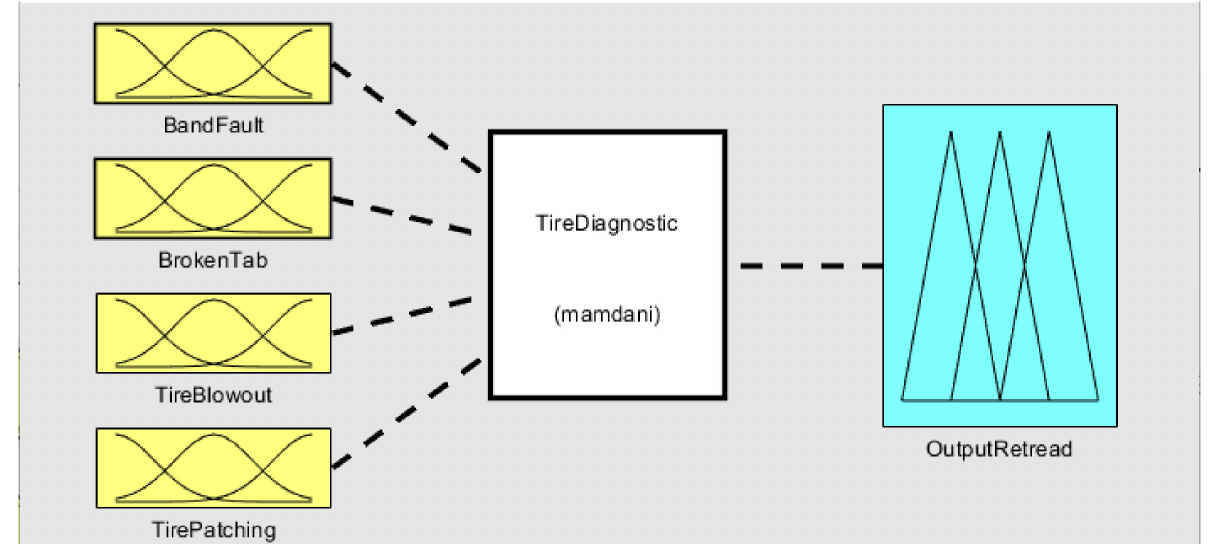
Figure 4. Tire Diagnostic Fuzzy Inference